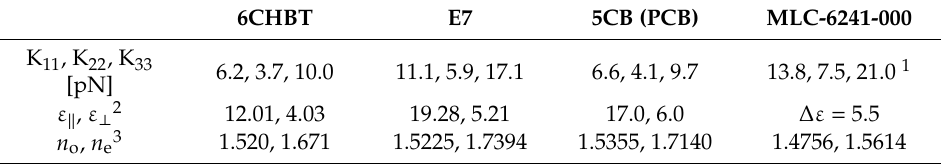
Table 1. Physical parameters of selected LCs with their values used in numerical